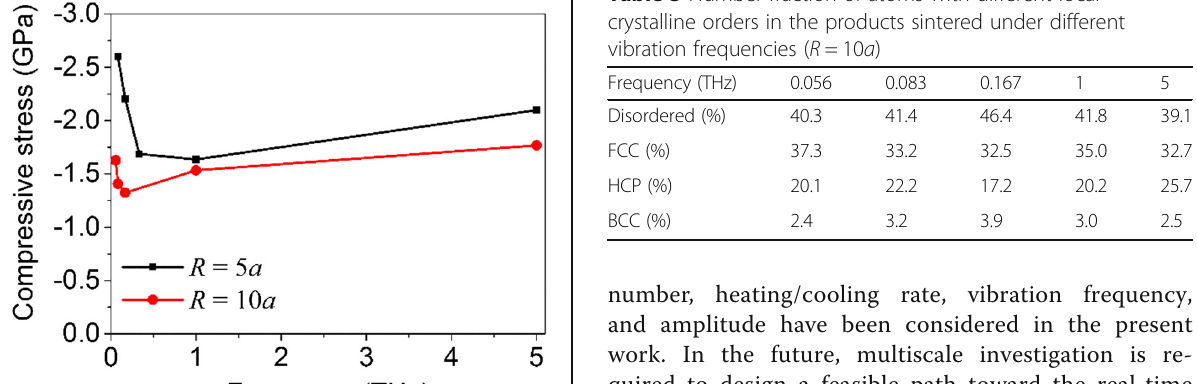
this process consists of two main phases, i.e., the nu- cleation phase and crystal growth phase. The final products equilibrated at the room temperature are mostly polycrystalline materials with grains separated by grain boundaries, stacking fault, twin boundary, etc. (2) The higher the heating rate, the later the ini- tial fusion of nanoparticles and the lesser the time of fusion stage. (3) External vibration could affect the evolution of nanostructures of the sintered products.